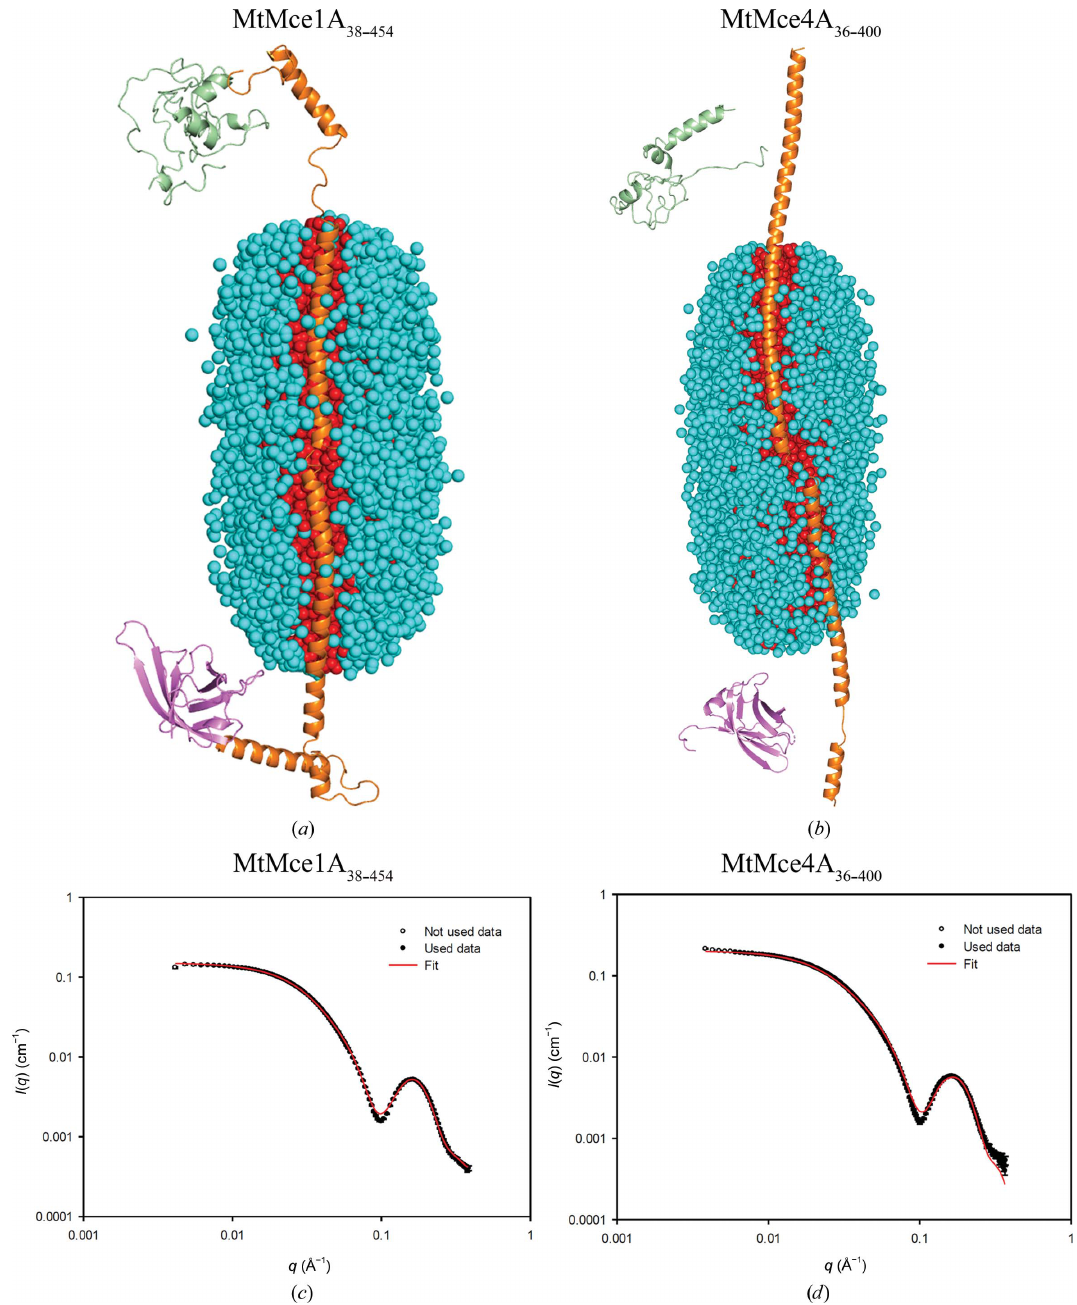
Figure 7 The extended helical models of ( a ) MtMce1A 38–454 and ( b ) MtMce4A 36–400 interacting with the core of the DDM micelle. The DDM molecules are represented as spheres and the protein as a cartoon. The model is represented by three domains: the MCE domain, helical domain and tail domain. The MCE domains of MtMce1A 38–454 and MtMce4A 36–400 are shown in magenta. The helical and tail domains are represented in orange and green, respectively, in both models. The DDM core and shell are shown in red and cyan, respectively. The MCE and the tail domains are not fully connected to the helical domain, as we used soft restraints between the three domains while fitting the model to the SAXS data to allow some flexibility. ( c , d ) The fits (red line) of the experimental SAXS data (black dots) to the proposed models of ( c ) MtMce1A 38–454 and ( d ) MtMce4A 36–400 are